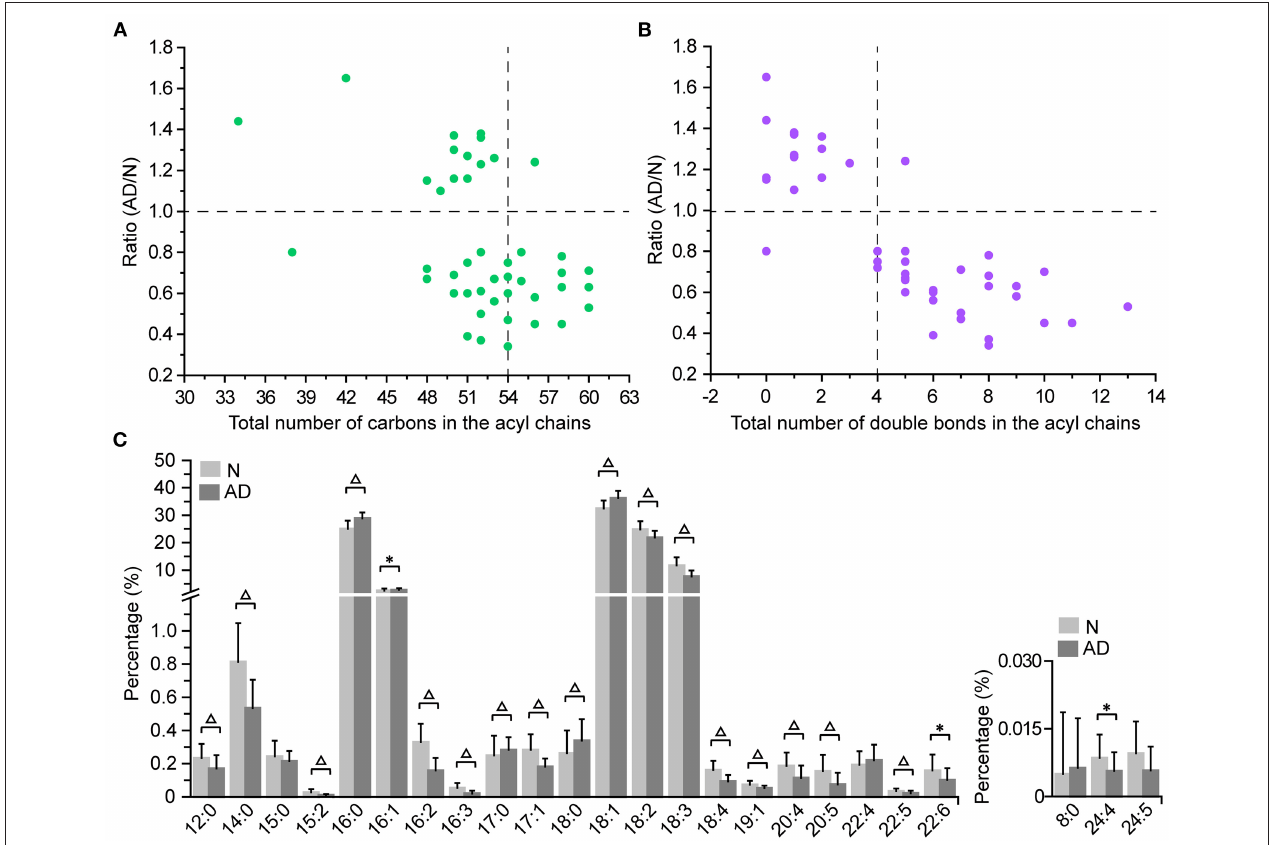
FIGURE 4 | Characteristic changes in the acyl chains of TGs in patients with AD. Changes in the total number of carbons (A) and double bonds (B) in the acyl chains of TGs. (C) Changes in the percentage of the acyl chains of TGs. The column denotes the mean plus standard deviation. n = 32 and 35 in the normal (N) and AD group, respectively. * P < 0.05; 1 P < 0.01, two-tailed Mann-Whitney U